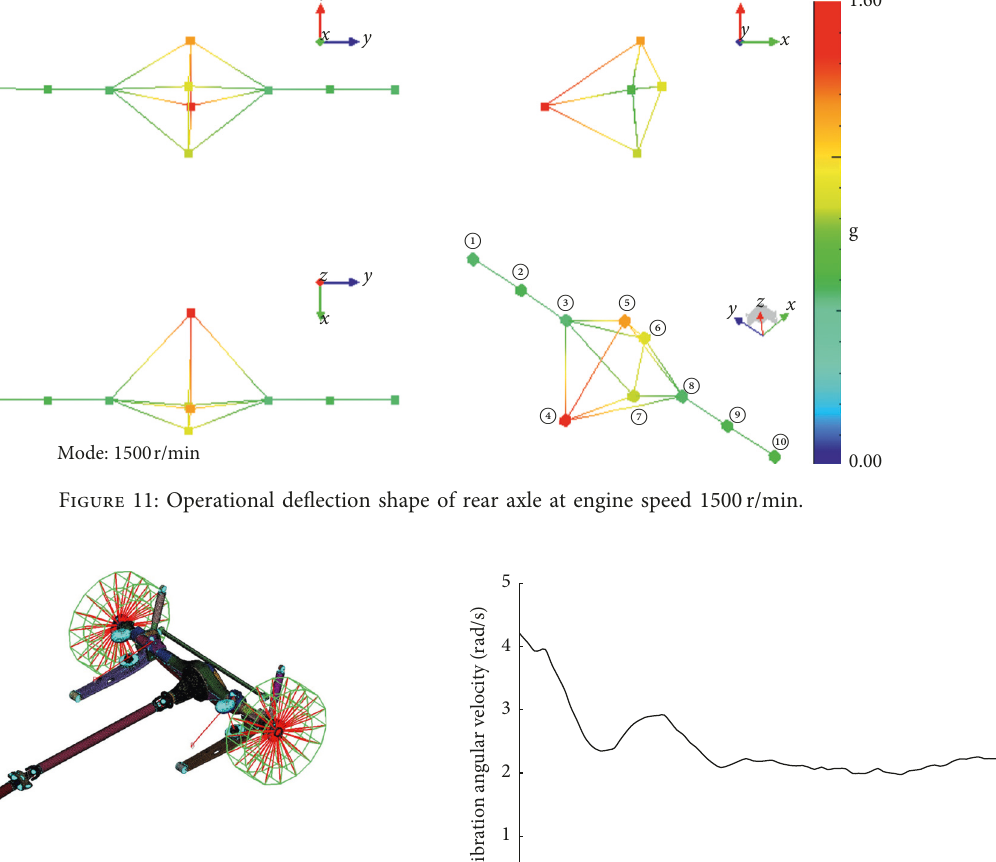
Figure 12: Multibody model of minivan rear suspension.